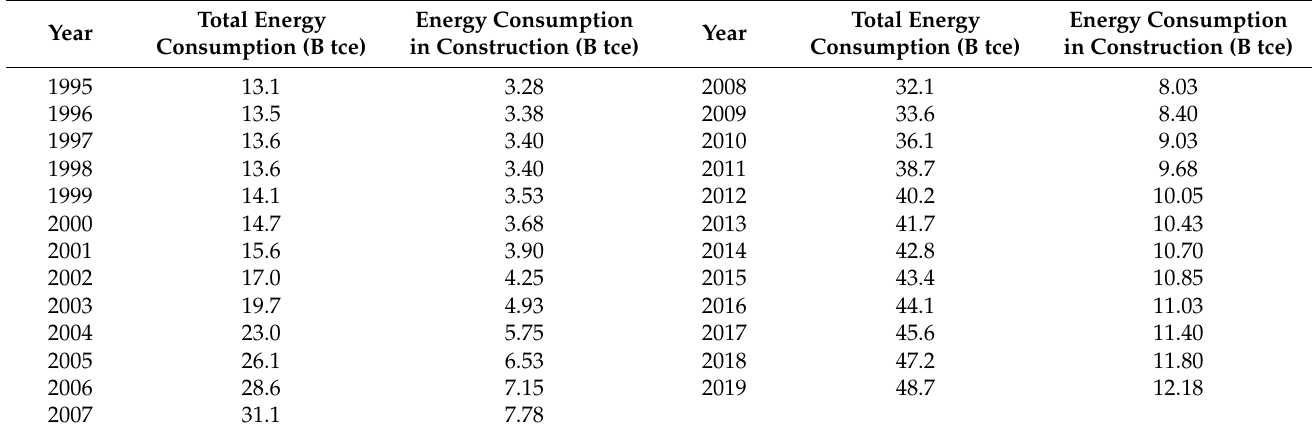
Table 4. Energy consumption of construction industry.